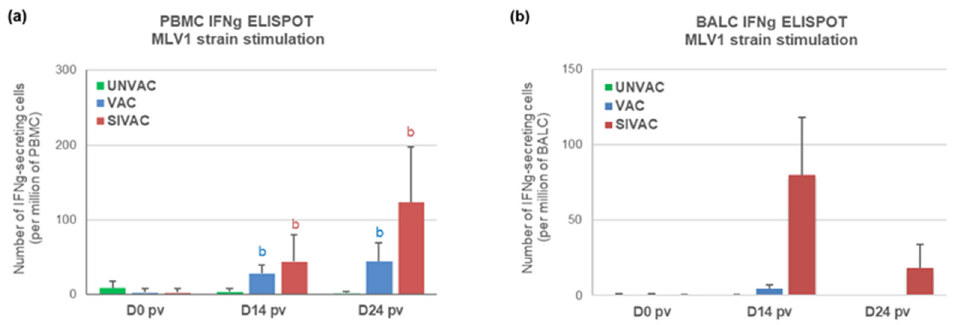
Figure 8. Anti-PRRSV cell-mediated immune response to the vaccine strain assessed by IFNg ELISPOT in ( a ) PBMC or in ( b ) BALCs. Data are reported as the mean (± SD) of the results obtained from all piglets in each group. Different letters (b,c) indicate that the considered group (specified by its color) was significantly different from the UNVAC group (b) or from the VAC group (c) with p < 0.05. There is no significance c found in these graphs.